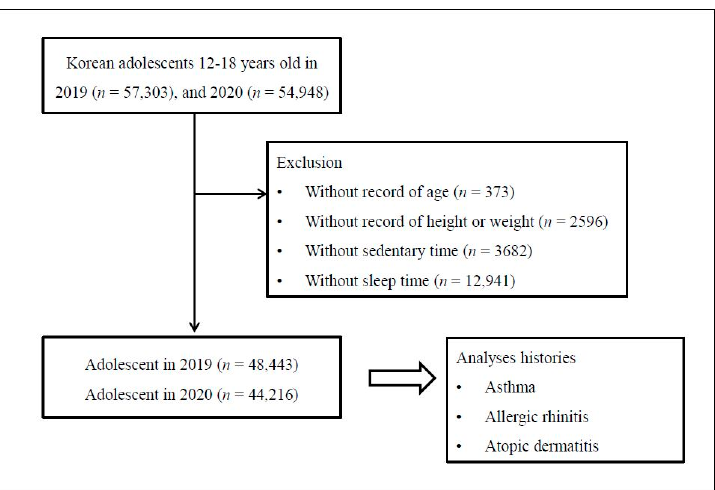
Figure 1. A schematic illustration of participant selection in the present study. Among 112,251 total participants (57,303 in 2019; 54,948 in 2020), 92,659 participants (48,443 in 2019; 44,216 in 2020) aged 12 through 18 years were included.